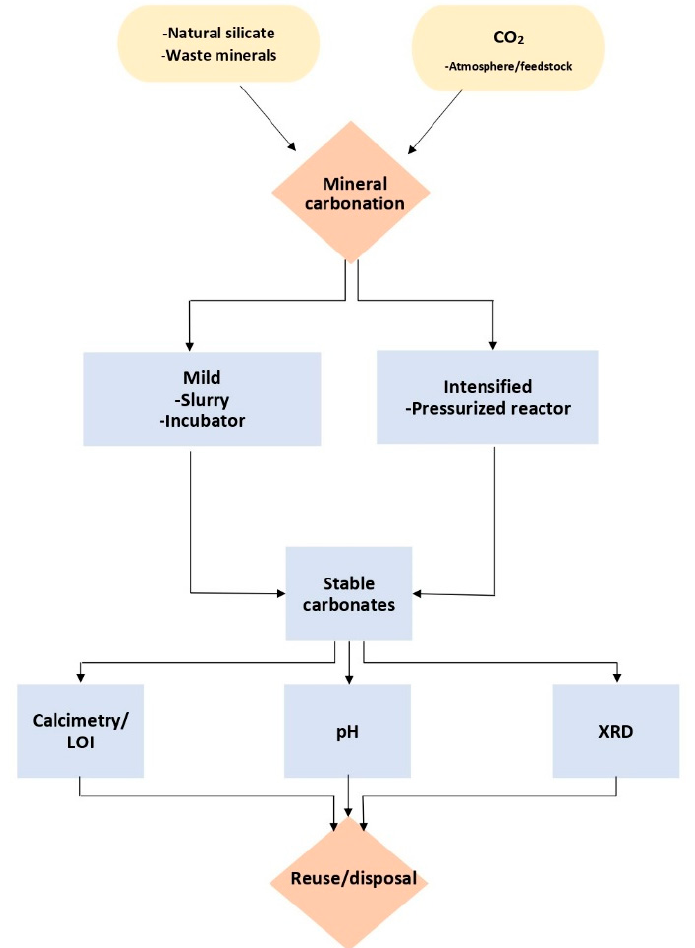
Figure 1. Schematic representation of mineral carbonation processes and materials characterization techniques used in this work.